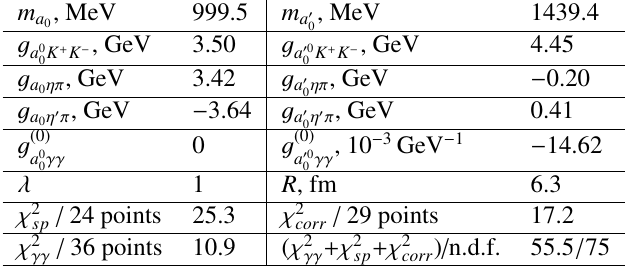
K + correlation: the solid line represents our fit, and the points are the experimental data S